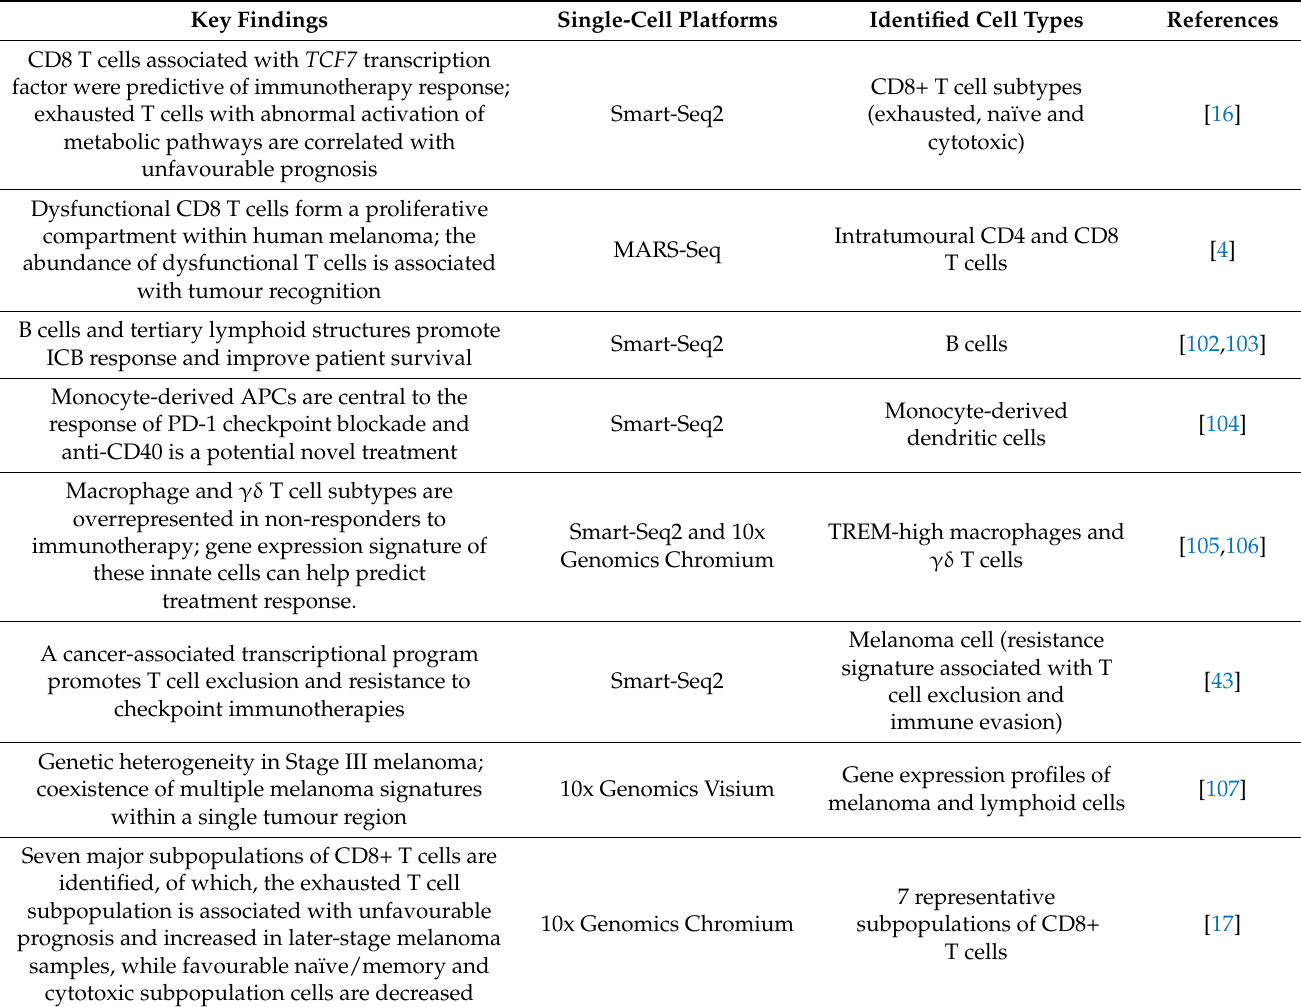
Table 3. Translational insights of immuno-oncology in melanoma from single-cell analyses. Key